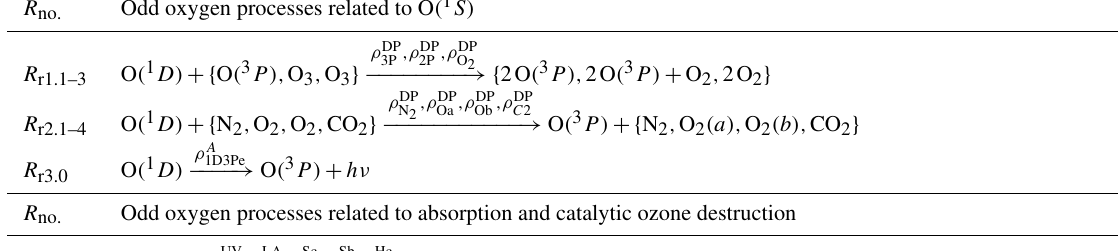
Table A1. Processes of the prior retrieval, continued from those shown in Table